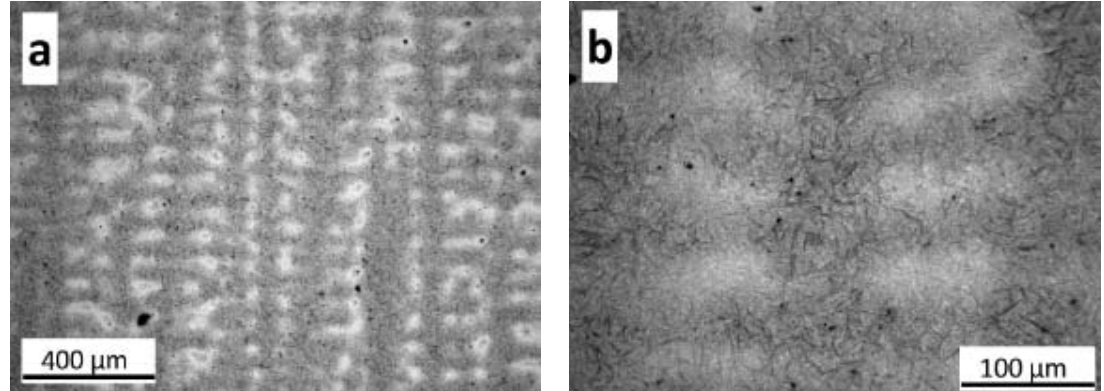
Figure 10. ( a ) Representative LOM micrographs of the as-quenched microstructure etched with Nital 2%; ( b ) higher magnification micrograph showing the dendritic (dark) and the interdendritic (lighter) zones. Non-metallic inclusions appear as dark round spots.